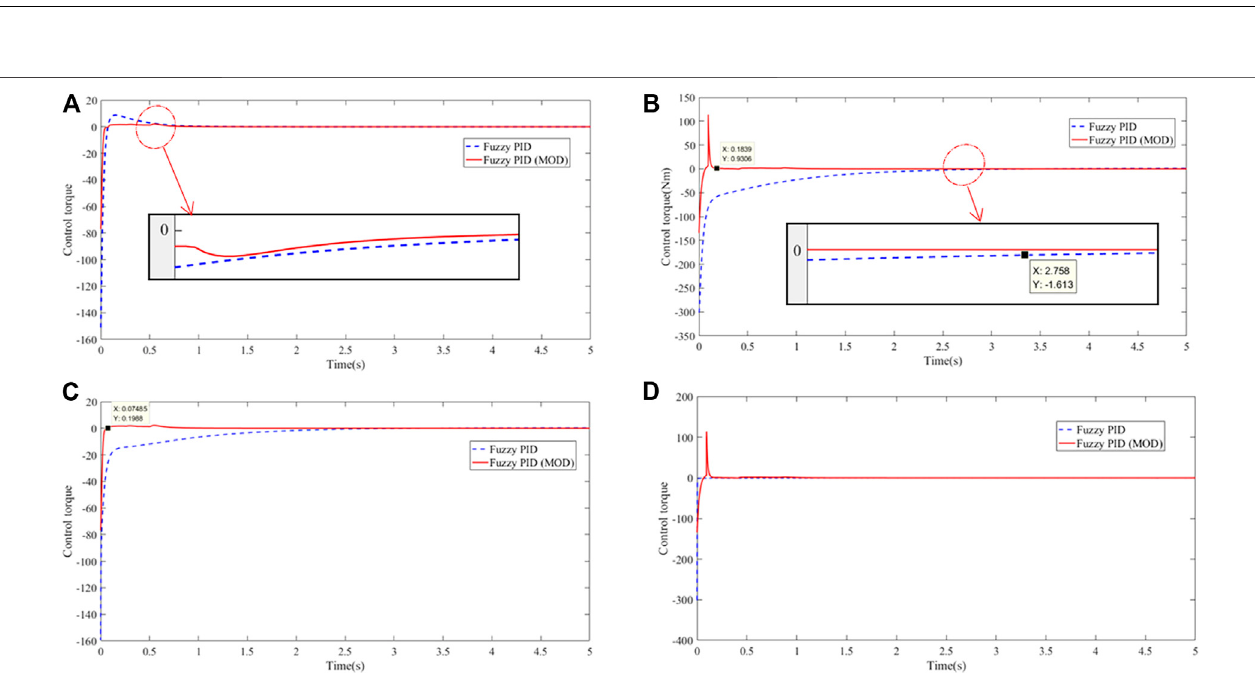
Frontiers in Bioengineering and Biotechnology |